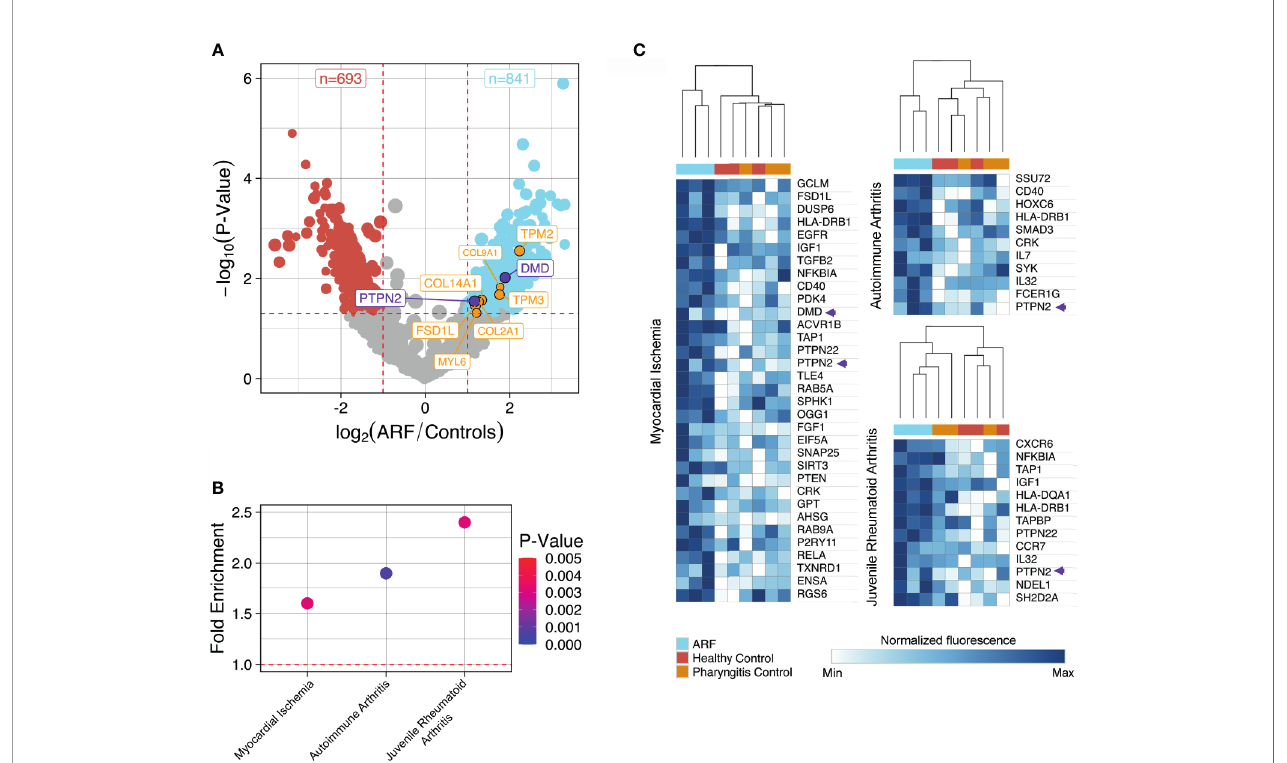
FIGURE 2 | Autoantibody disease pathway analysis using ProtoArray data. (A) Volcano plot showing fold-change differences in autoantibody signals between ARF patients (n=3) and controls (n=6). Controls comprise both healthy children (n=3) and children with GAS positive pharyngitis (n=3). The size of the dots and annotations relates to the fl uorescence intensity of individual autoantibodies. Red dashed lines indicate cut-offs for signi fi cant differences (p < 0.05, fold-change >2). Blue dots represent autoantibodies showing signi fi cantly increased binding in ARF patients compared to controls whilst red dots represent autoantibodies showing signi fi cantly increased binding in controls compared to ARF patients. Orange annotated autoantibodies have historically been implicated in the pathogenesis of ARF and/or RHD. Purple annotated autoantibodies are novel and of interest for downstream analysis (see Figure 3 ). (B) Disease pathway analysis conducted on 841 autoantigens with signi fi cantly increased binding in ARF patient sera in part (A). Three signi fi cant (p < 0.005) disease pathways are shown in relation to fold enrichment of proteins in pathways (compared to what would be expected by chance). Dot color intensity corresponds to p-value and dashed red line indicates a fold-enrichment of 1, which would represent no enrichment. (C) Heat-maps showing individual autoantibody reactivities to proteins belonging to disease pathways identi fi ed in part (B). Color intensity corresponds to log 2 normalized fl uorescence values from ProtoArrays of each individual ARF patient (blue columns), healthy controls (red columns) and children with GAS positive pharyngitis (orange columns). A relative color scheme was applied using the min and max values in each row to plot relative colors. The dendrogram represents results of hierarchical clustering on columns. Autoantibody reactivities indicated by purple arrows relate to novel autoantibodies of interest for downstream analysis